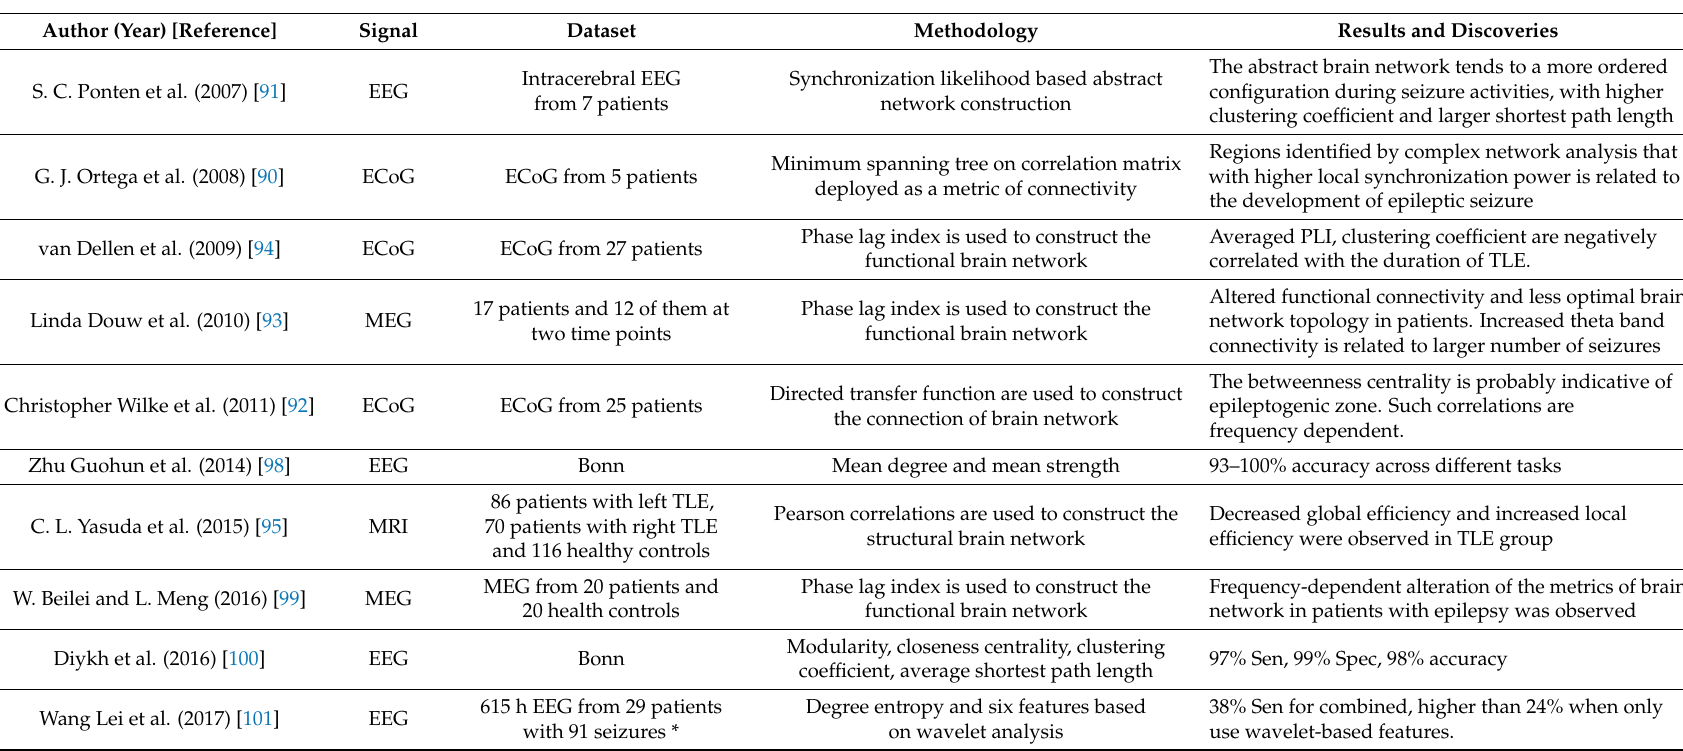
Table 3. Epileptic Seizure Monitoring inspired by Network Science (Sen: Sensitivity. Spec: Specificity. FDR: False detection rate. “*” indicates nonpublic